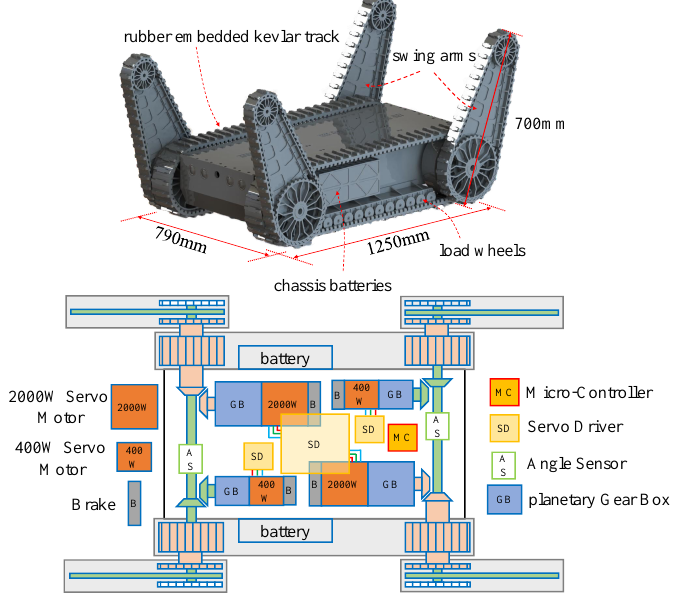
Figure 2. Mechanical dimensions and internal layout of the mobile